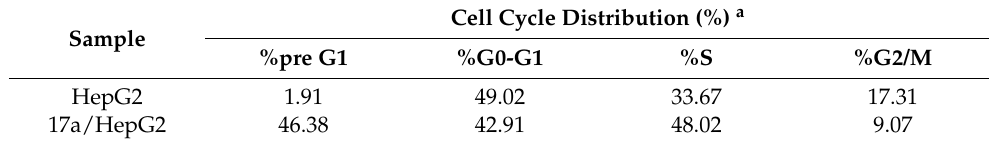
Table 3. Effect of compound 17a on cell cycle distribution in HepG2.